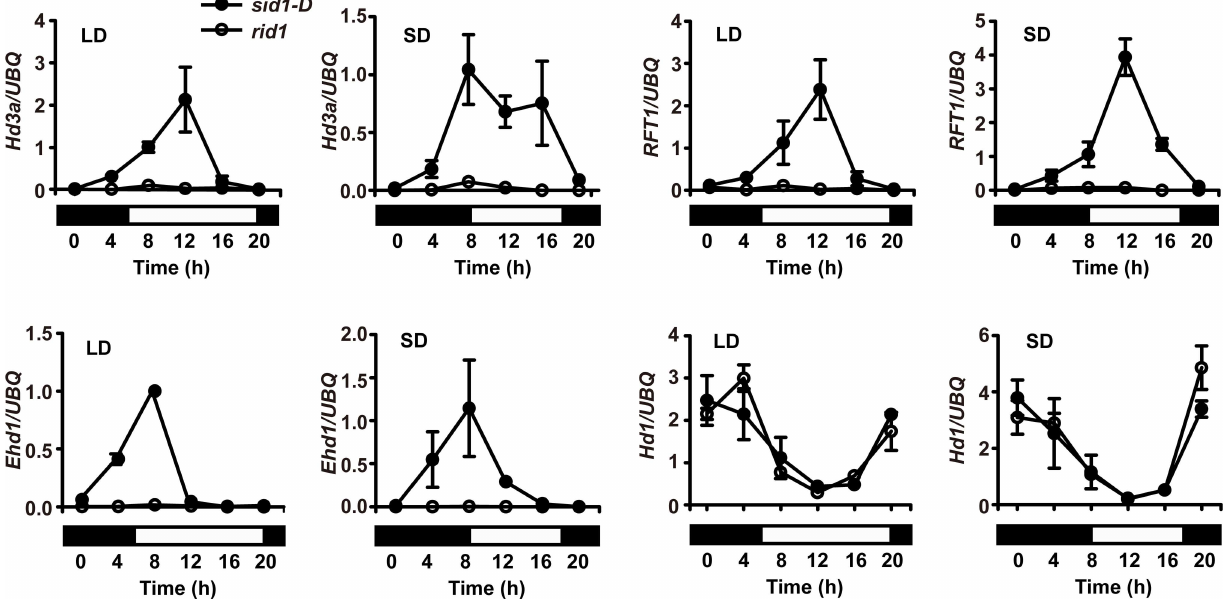
Fig 6. Expression patterns of flowering-related genes in sid1-D . The expressionof Hd3a , RFT1 , and Ehd1 , but not Hd1 , were elevated and diurnal in sid1-D plants under both long-day(LD) and short-day (SD) conditions. The open and filled boxes at the bottom represent the light and dark periods, respectively. The rice UBQ gene was used as the internalcontrol. Valuesare shownas means ± SEMs of three biologicalreplicatesand each with two technical